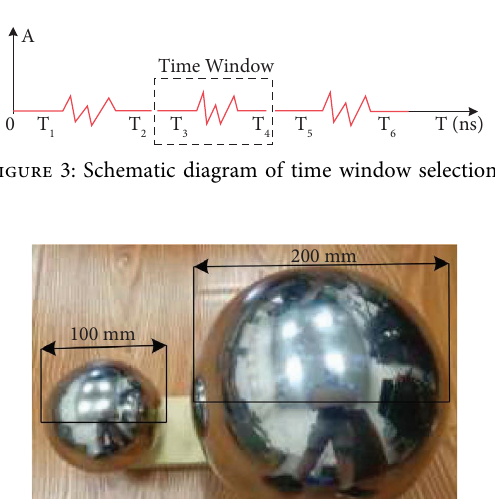
Figure 2: Pulse source time domain waveform and frequency spectrum. (a) Time domain pulse waveform and (b) pulse spectrum.